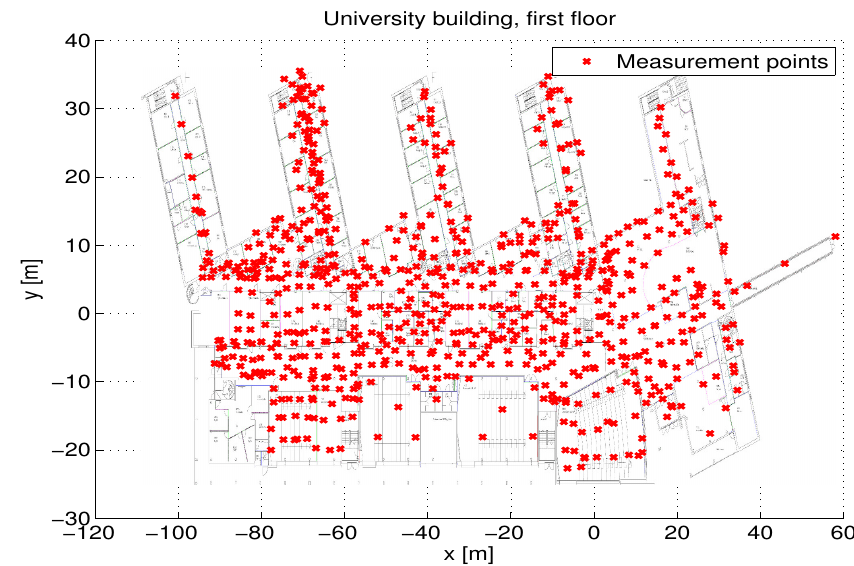
Figure 3. Measurement points in the first floor of UBldg1.